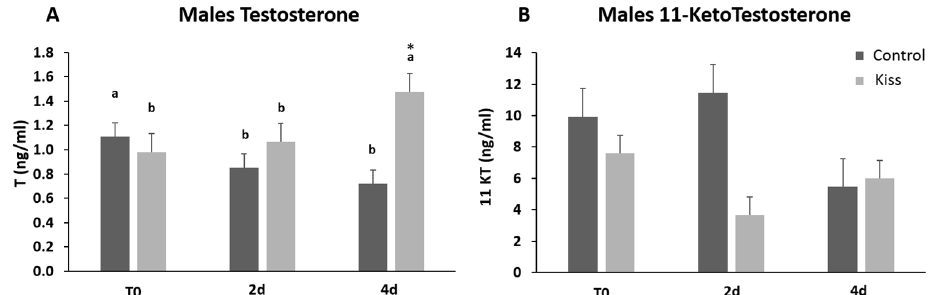
Figure 6. Sexual steroids plasma levels in ng / mL (mean ± SEM) from Senegalese sole males treated with kisspeptin hormone ( n = 17) and control ( n = 13). ( A ) Testosterone and ( B ) 11-Ketotestosterone